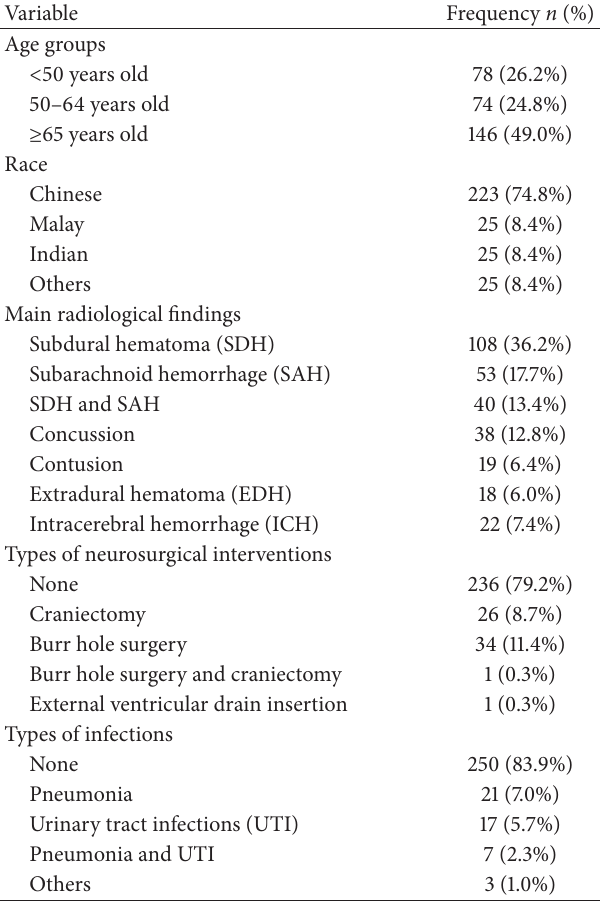
Table 3: Demographics and clinical variables of patients with TBI ( 𝑁 = 298 ).